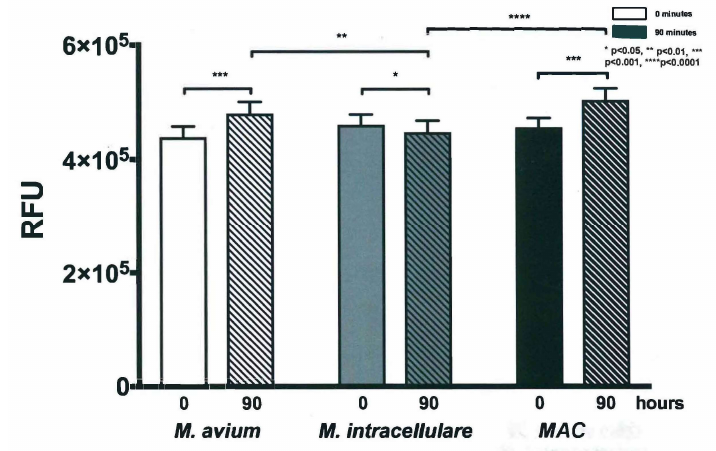
Figure 5. Cellular metabolic activity of M. avium , M. intracellulare , and MAC ( M. avium combined with M. intracellulare ) over 90 h. A cyclic trend was observed, n = 7.